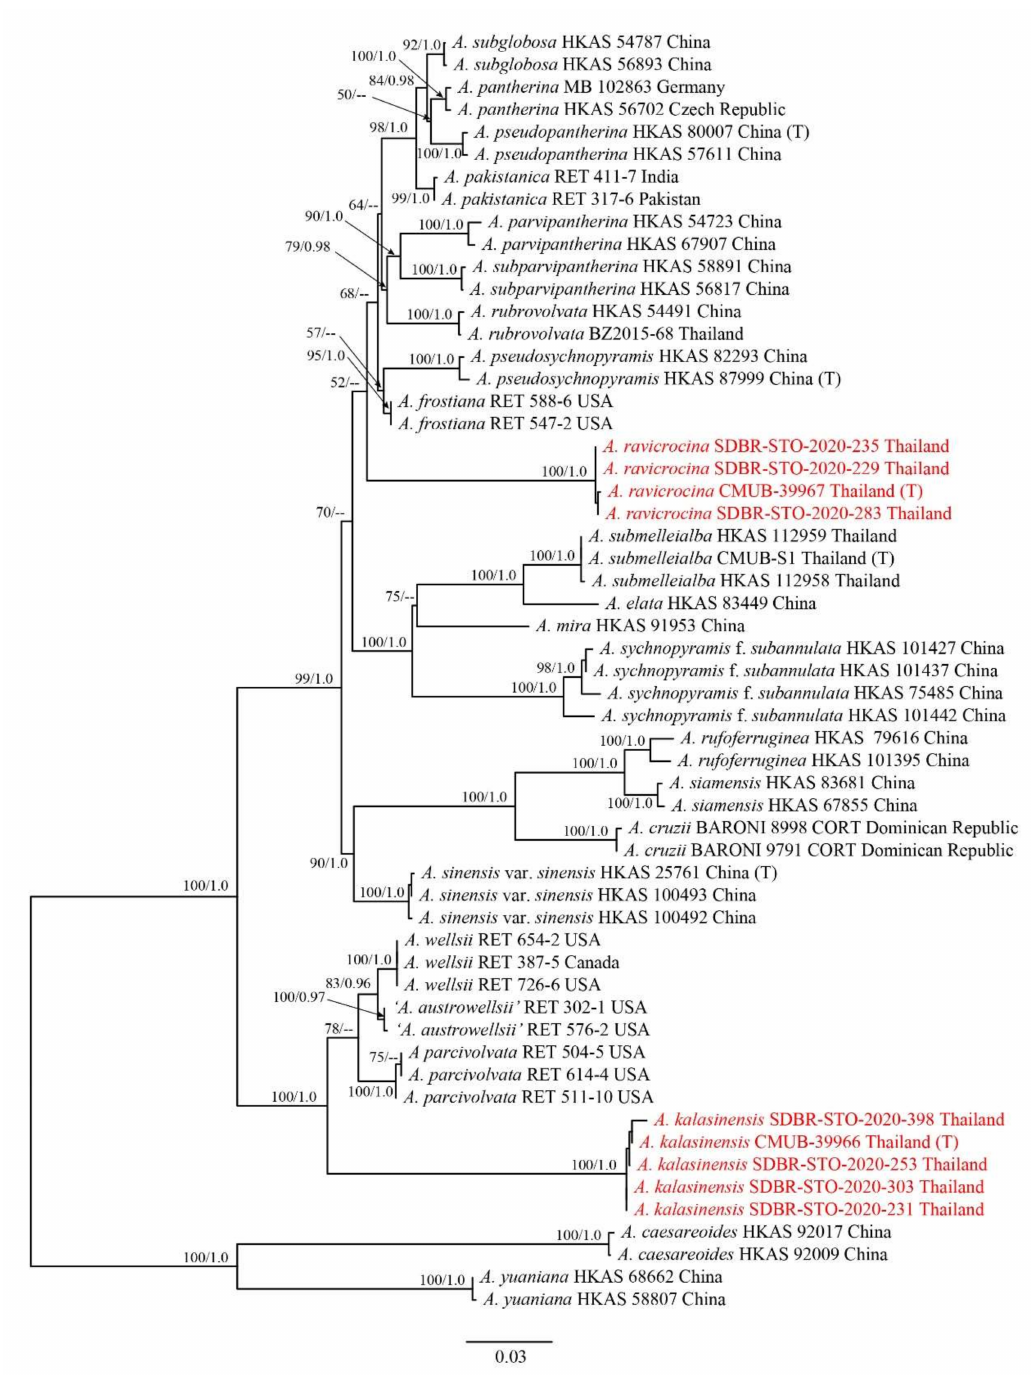
Figure 1. RAxML tree based on a combined of ITS + nrLSU + RPB 2 + TEF 1- α + TUB dataset. Bootstrap values (BS) for ML ≥ 50% and posterior probabilities (PP) for BI ≥ 0.95 are placed above or below the branches, respectively. Newly generated sequences are indicated in red and sequences from type material are marked with (T). The tree is rooted with Amanita yuaniana (HKAS58807 and HKAS68662) and A. caesareoides (HKAS92009 and